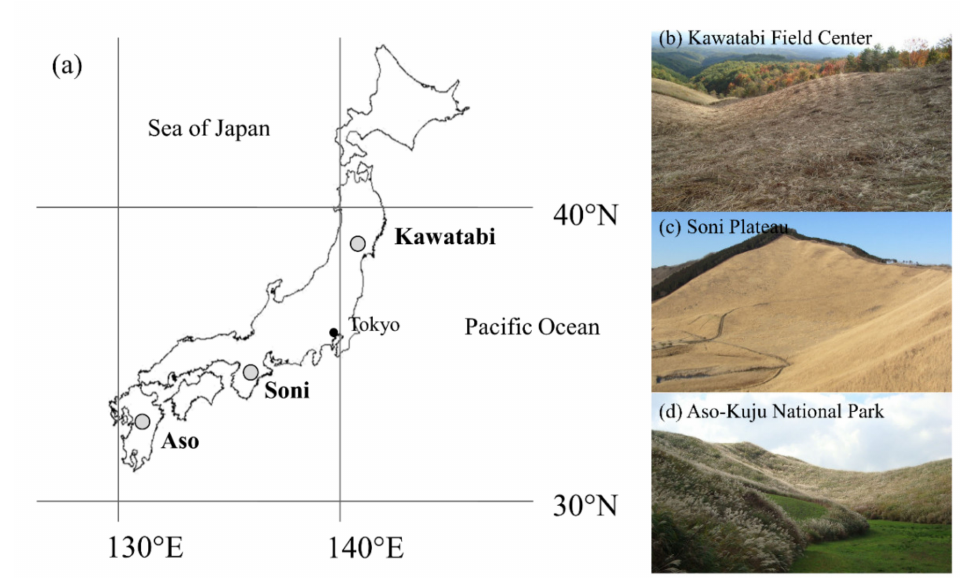
Figure 1. Locations of the semi-natural Miscanthus sinensis grassland study sites in Japan ( a ) and the semi-natural Miscanthus grassland study sites of the Kawatabi Field Science Center, Miyagi Prefecture ( b ); Soni Plateau, Nara Prefecture ( c ); Aso-Kuju National Park, Kumamoto Prefecture ( d